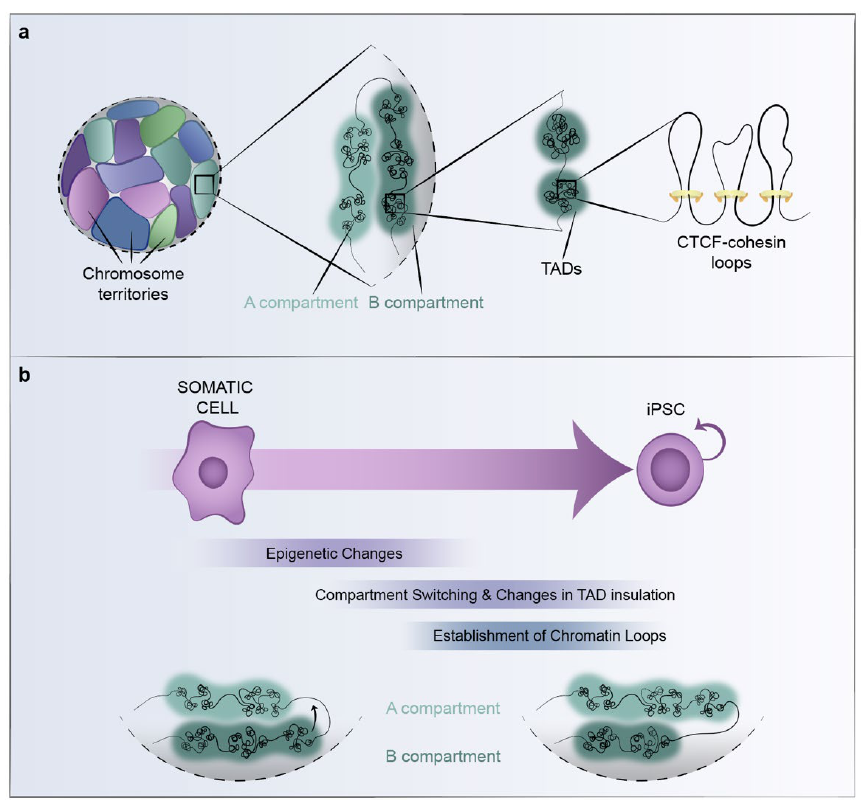
Figure 2. 3D chromatin organization and reprogramming. ( a ) The spatial organization of the genome at multiple scales: Individual chromosomes occupy distinct chromosome territories, within which active and inactive chromatin segregate into A and B compartments, respectively. A-compartments localize towards the interior of the nucleus, while B-compartments are positioned towards the periphery and are enriched at the nuclear lamina. At smaller scales, chromatin is organized in TADs within which gene expression is controlled by functional dynamic interactions between promoters and enhancers. CTCF and cohesin play an architectural role in the 3D organization of the genome. ( b ) Dynamics of genome organization during reprogramming: Reprogramming to pluripotency involves a series of changes in the genome organization of the somatic cells into that of the iPSCs, including epigenetic changes, compartment switching, changes in TAD insulation and establishment of chromatin loops. The bottom panel represents compartment switching during reprogramming— here illustrated by a domain at the B-compartment in somatic cells that switches into the A-